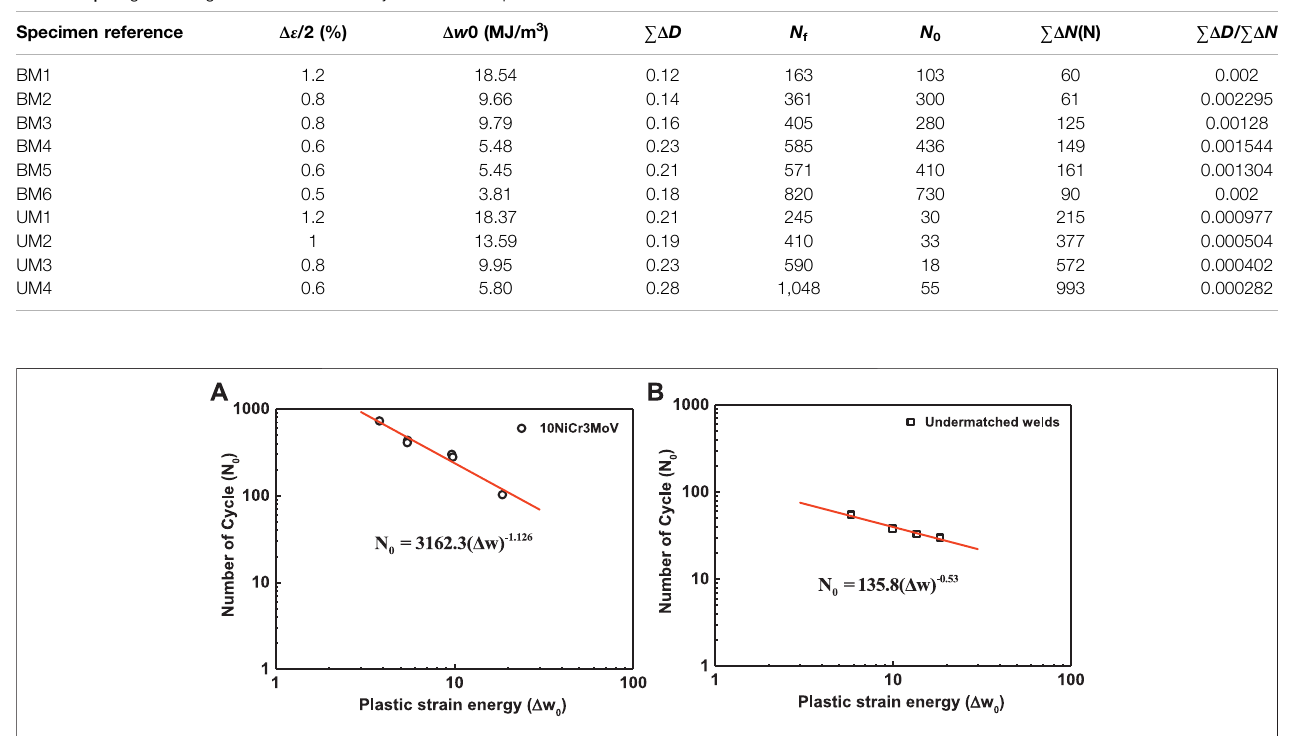
FIGURE 12 | The log – log relationship between Δ w 0 and fatigue life in the initial stage. (A) 10CrNi3MoV steel and (B) undermatched welds.